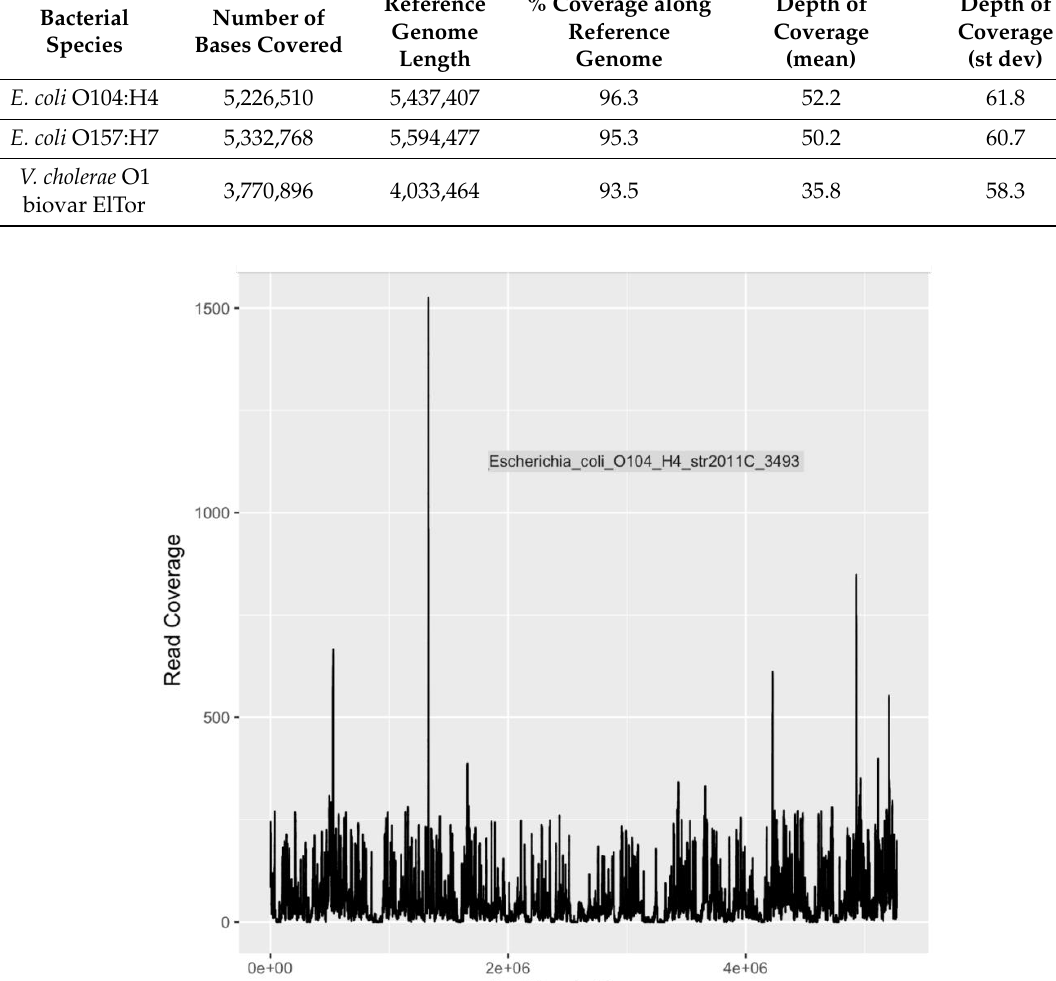
Figure 3. Sequencing coverage plot for E. coli O104:H4.